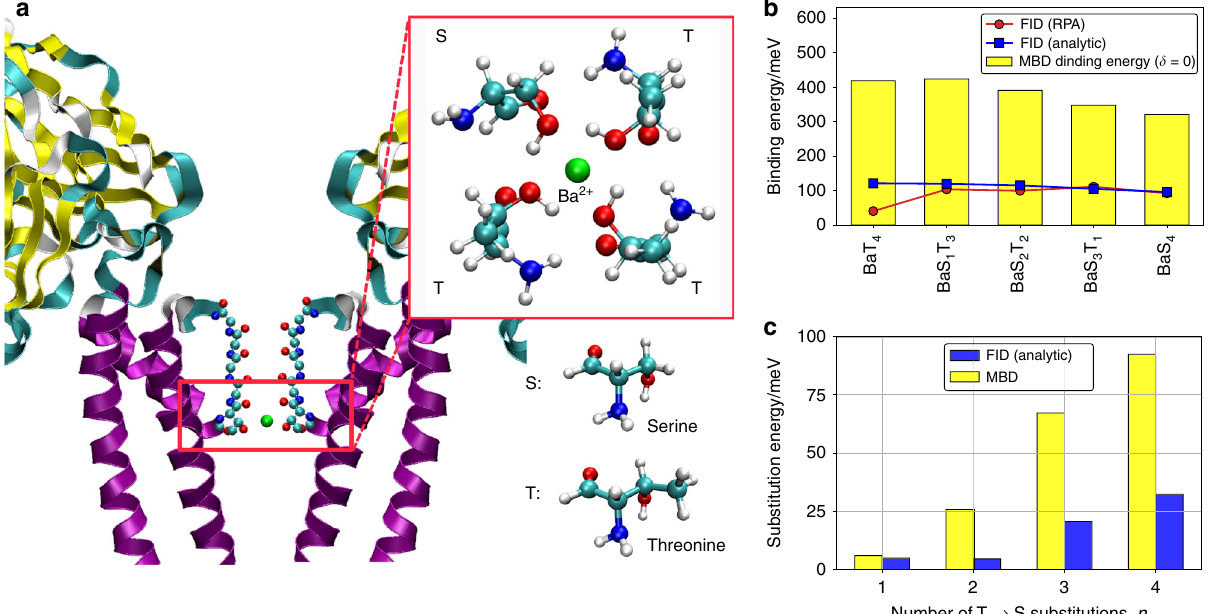
Fig. 4 Field-induced dispersion effect in the selectivity fi lter of Kcv ion channel. a Cross section of selectivity fi lter of a representative Ba 2 + ion channel 59 and zoomed S4 region with three threonine and one serine molecule (BaT 3 S 1 ); b Absolute value of FID W bind c ð δ ¼ þ 2 Þ (in meV) obtained from numerical RPA correlations (red line) and analytic Eq. (2) (blue line) compared with the MBD energy (yellow bars) for the Ba 2 + complex with four amino-acid ligands; c Substitutional MBD energies (shown in yellow) and substitutional FID energy contribution (blue) for the same ion